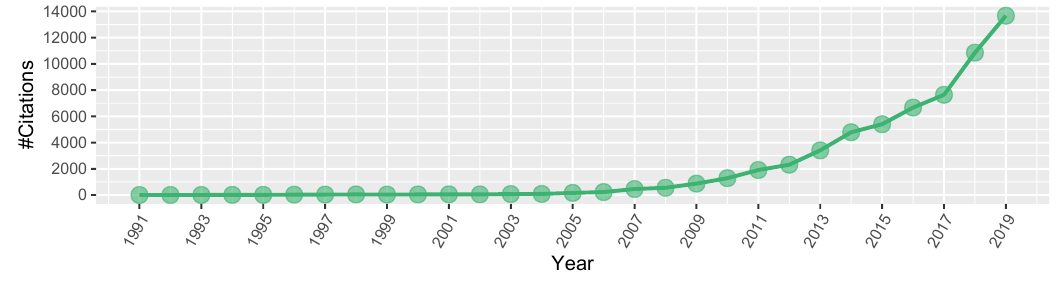
Figure 5. Sum of times cited per Year.